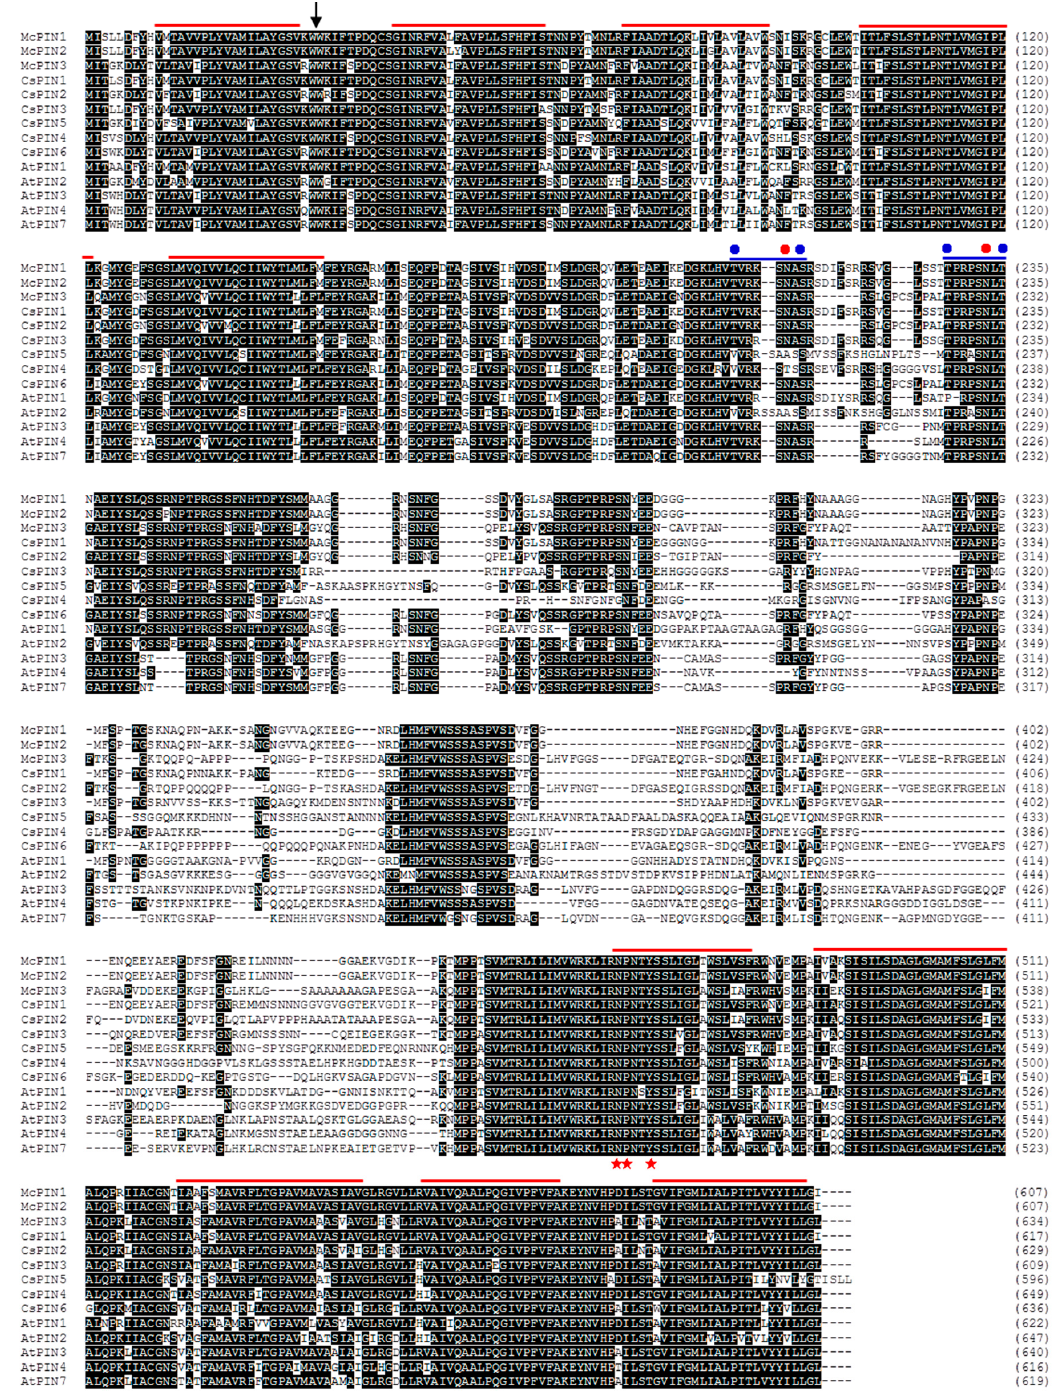
Figure 1. Comparison of amino acid sequences among auxin efflux carriers from bitter gourd (McPIN1 to 3), and cucumber (CsPIN1 to 6). Gaps have been introduced to maximize the alignments. Amino acid sequences were aligned using the AlignX program of Vector NTI Suite 10.0 software. An arrow indicates the cleavage site of a potential signal peptide analyzed by SignalP 3.0 [21]. Conserved transmembrane domains are indicated by red bars above sequences. Putative clusters (blue bar) of glycosylation (red dot) and two phosphorylation sites (blue dot) are indicated. Red stars indicate the internalization motif NPXXY [22]. GenBank accession numbers are AF247004 (McPIN1), AF246995 (McPIN2), AF247005 (McPIN3), AB085897 (CsPIN1), and AF539049–AF539053 (CsPIN2 to 6).